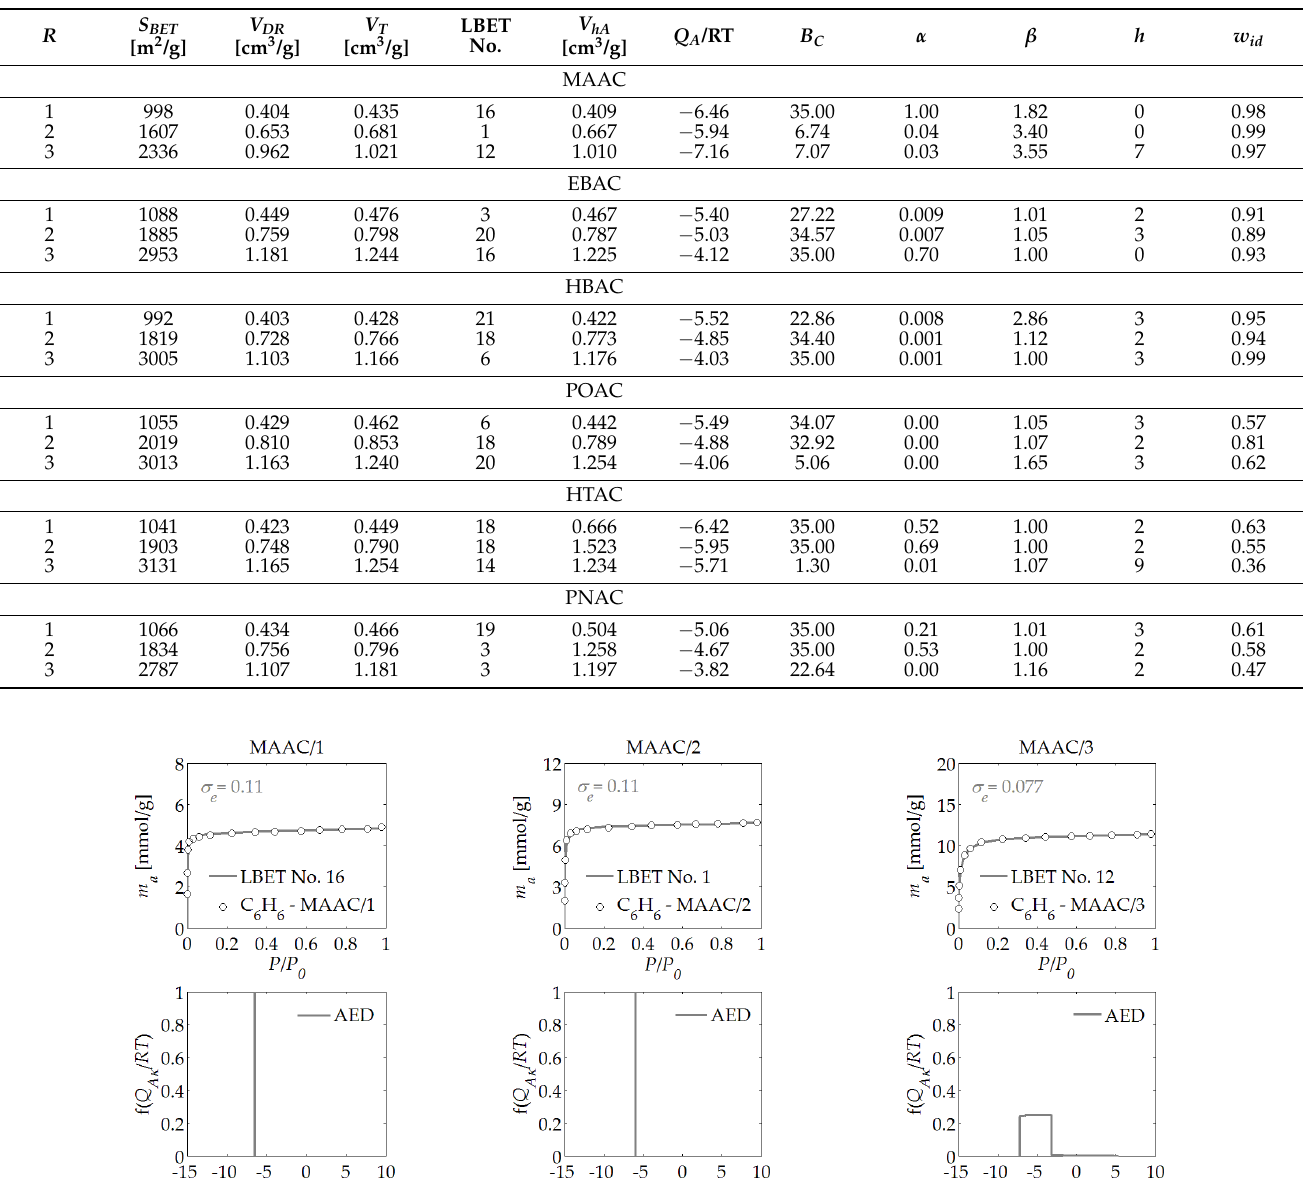
Table 1. Parameters of the porous structure of activated carbons derived from mahogany wood (MAAC/ R ), ebony wood (EBAC/ R ), hornbeam wood (HBAC/ R ), pistachio nut shells (POAC/ R ), hazelnut shells (HTAC/ R ), and pecan nut shells (PNAC/ R ), as calculated from the isotherms of benzene.